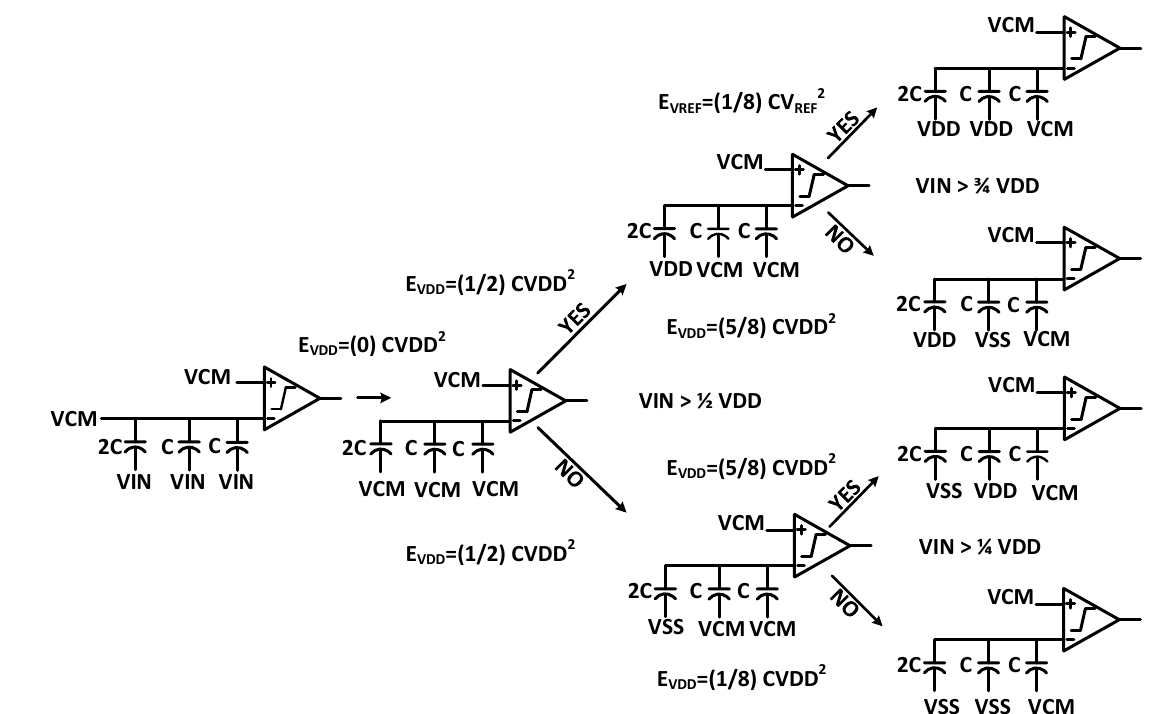
Figure 3. The proposed 3-bit switching method for single-input SAR ADC.